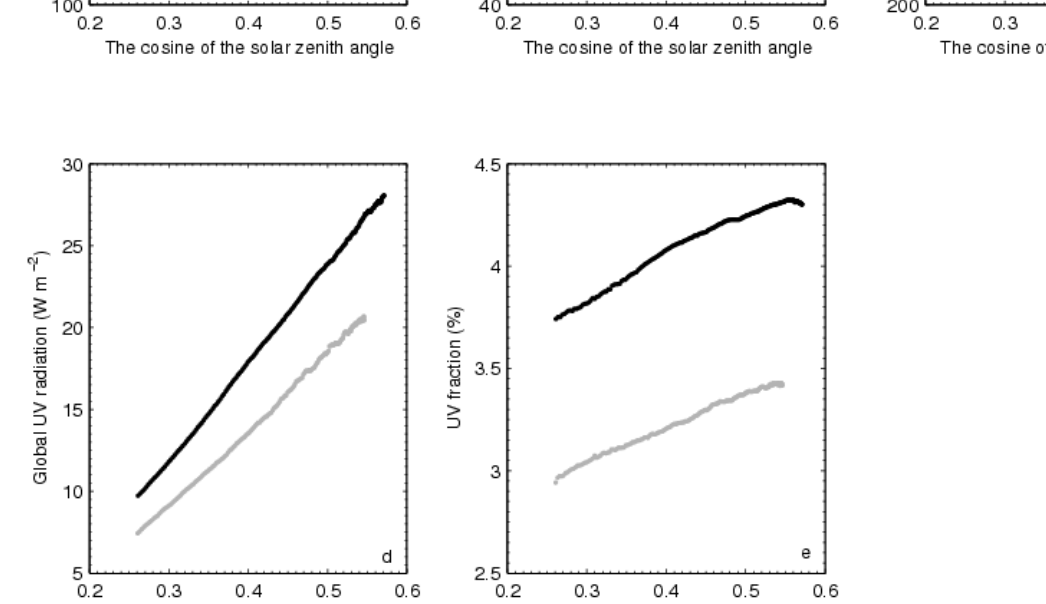
Fig. 2. Comparison of direct, diffuse, global SW, UV radiation and UV fraction between two days: 2 February 2005 and 8 February 2006. Figure 2. Comparison of direct, diffuse, global SW, UV radiation and UV fraction The attenuation of solar radiation is nearly identical but the ground is snow covered on 8 February 2006 and not on 2 February 2005.